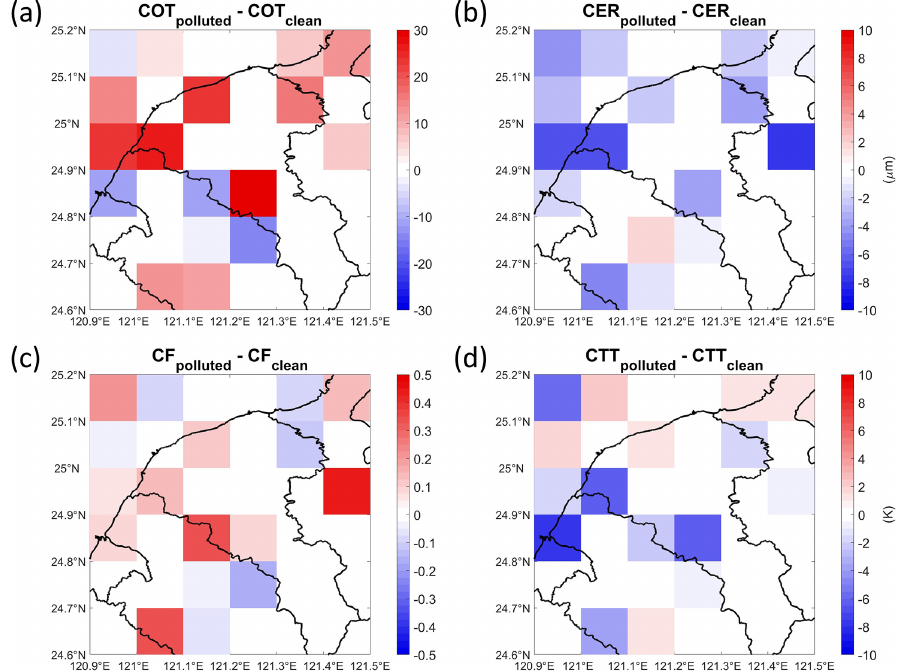
Figure 7. Difference in (a) COT, (b) CER, (c) CF, and (d) CTT between polluted days and clean days in group 9 (150 ≤ CWP < 297).